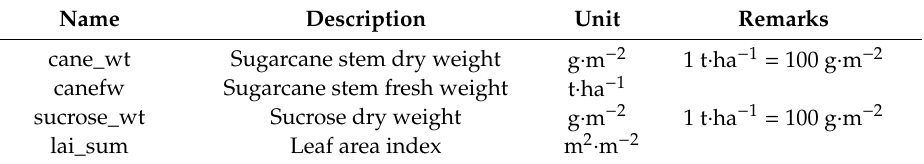
Table 9. Explanation of the selected output indicators for the parameter sensitivity analysis.